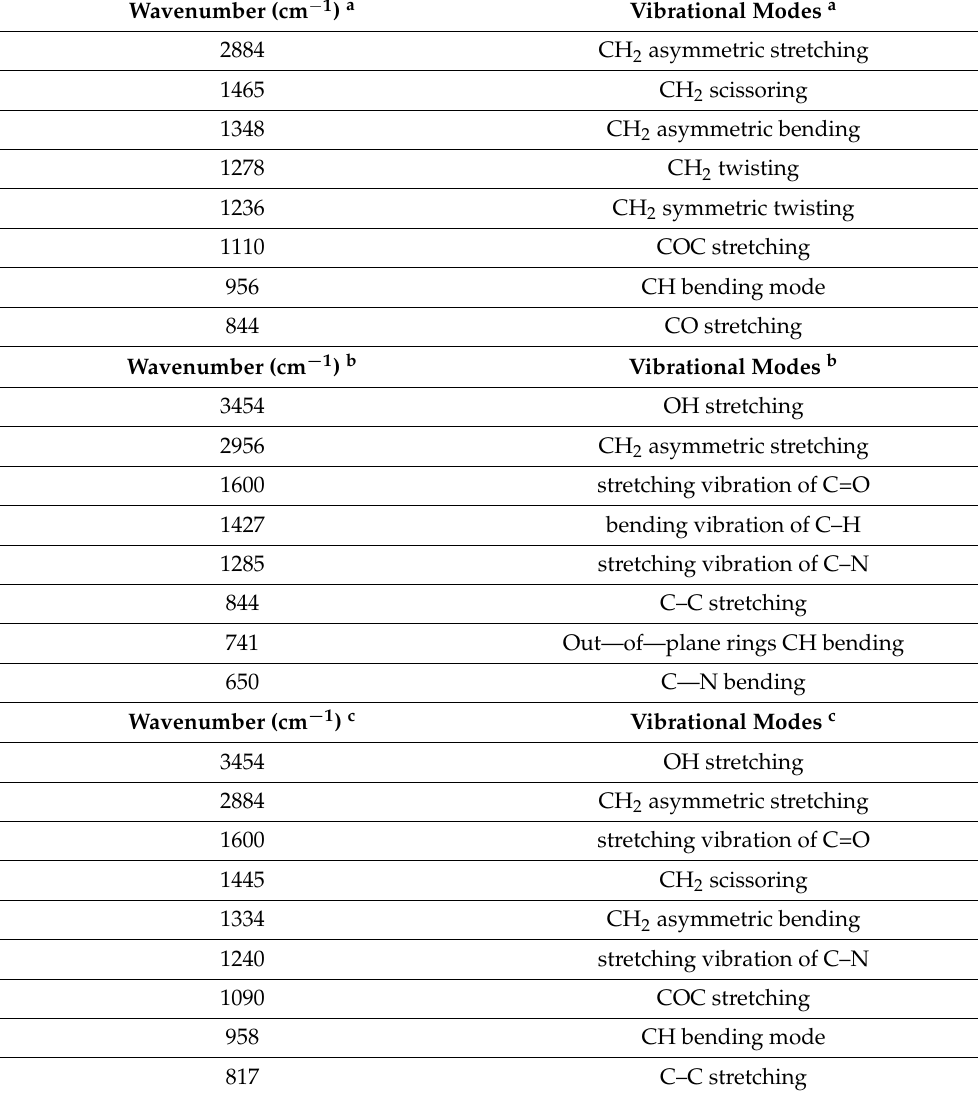
Table 1. The FTIR characterization peaks for PEO, CMC, and the PEO/CMC